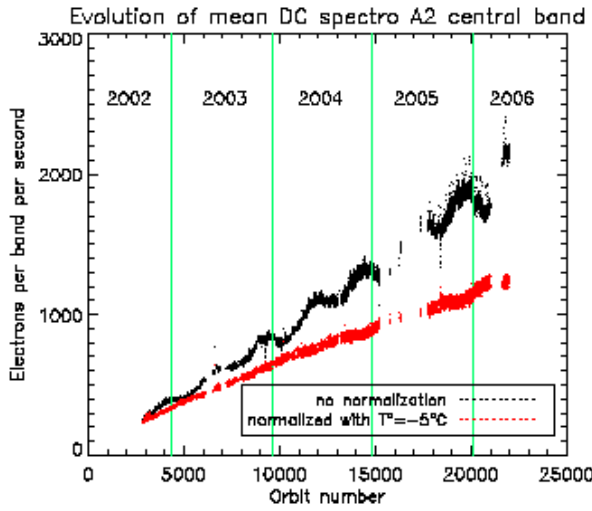
Fig. 18. Mean Dark Charge for spectrometer A2. The black curve shows seasonal variations due to the position of the sun and thus to the change of the temperature of the CCD. The red curve has been obtained by normalizing the black curve at a reference temperature of -5°C. Therefore, the red curve shows that an increase of Dark Charge independent of the temperature still exists, due to radiation damage.